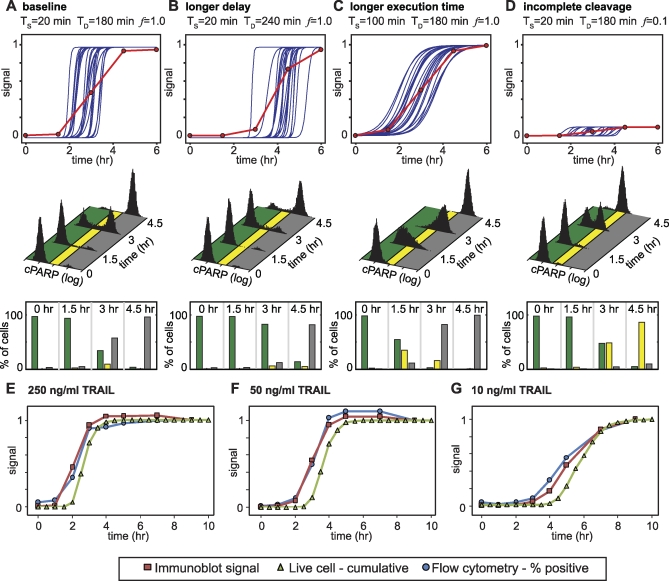
Simulation-Based Approach to Data Fusion for Three Different Measures of Caspase Activity(A, B, C, D) Simulated live-cell (top, twenty individual cells shown as blue lines), immunoblot (top, red lines), raw flow cytometry (middle, computed from 10,000 simulated live-cell profiles), and discretized flow cytometry data (bottom) for four different sets of switching parameters: (A) Baseline, corresponding to 250 ng/ml TRAIL; (B) an increase in mean Td to 240 min. (C) An increase in Ts to 100 min (D) or a decrease in f to 0.1.(E, F, G) Concordance of data on EC substrate cleavage as obtained from immunoblot, flow cytometry, and live-cell assays in HeLa cells treated with 250 ng/ml (E), 50 ng/ml (F), or 10 ng/ml (G) TRAIL. Values for immunoblots are derived from quantitating the cleaved 89 kDa form of PARP by immunoblot; flow cytometry values represent the percentage of cPARP-positive cells computed as described in the legend of Figure 2, and live cell data were computed as the cumulative percentages of dead cells for populations of >150 cells. To facilitate comparisons, all three signals were normalized to their final value.